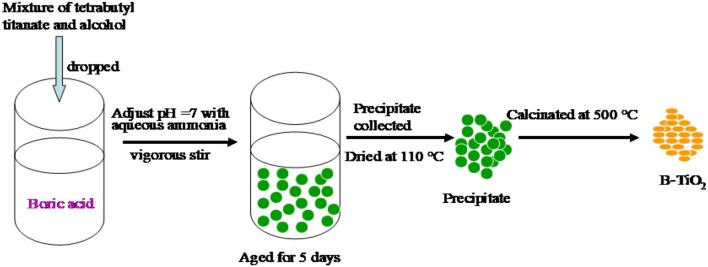
Synthesis scheme of B-TiO2.